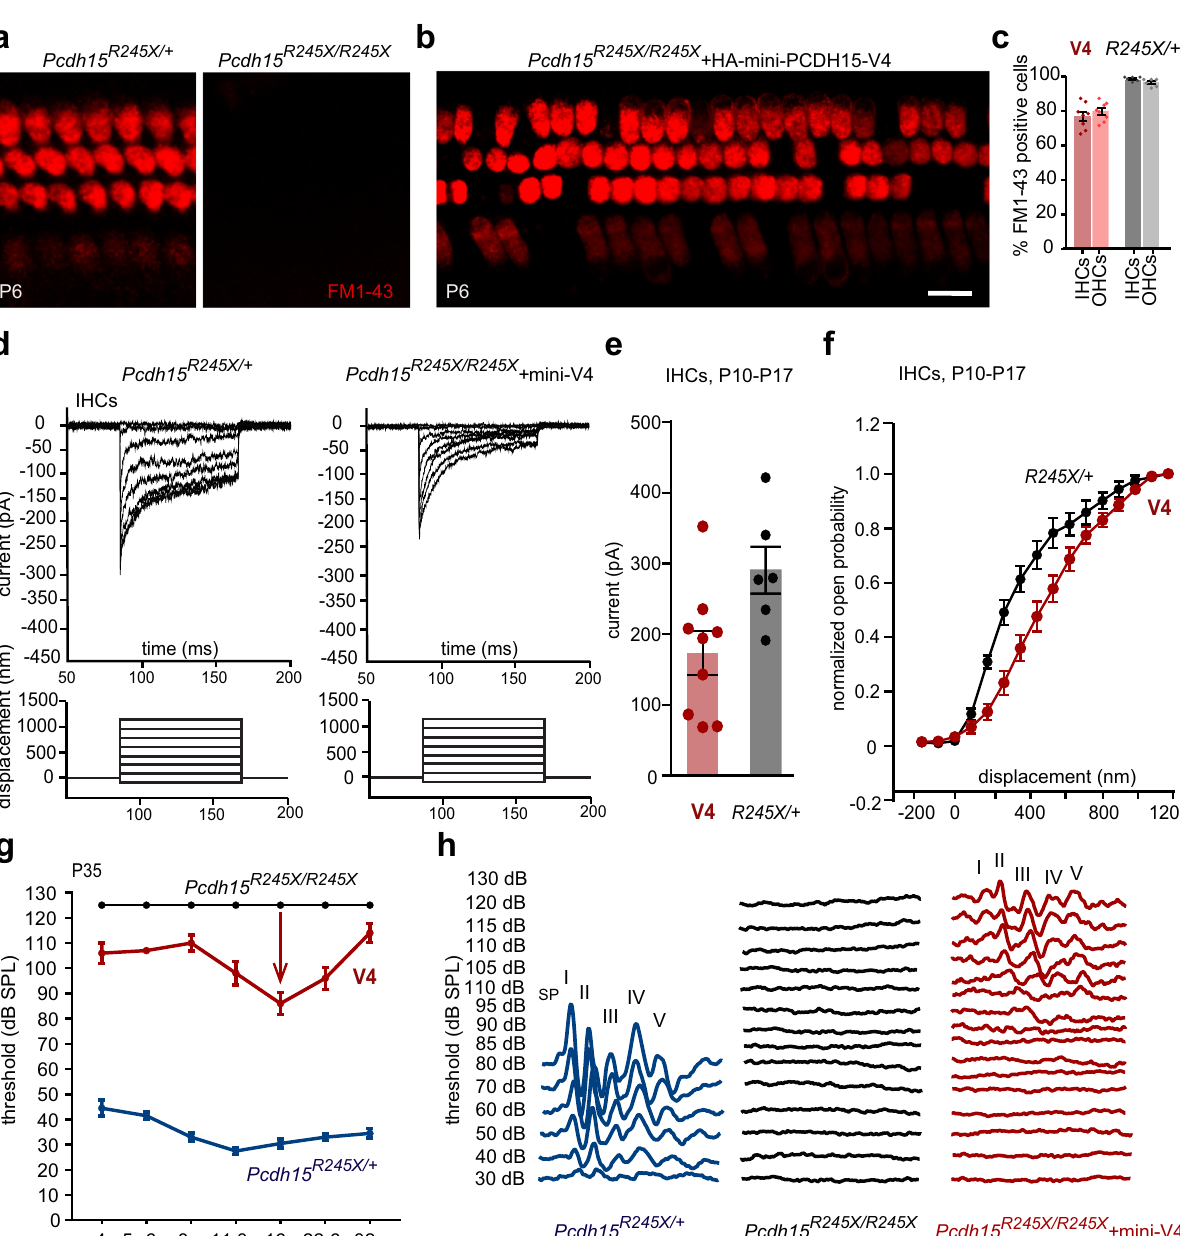
transduction currents at P10-P17 from Pcdh15 R245X/+ controls ( n =6 cells) and Pcdh15 R245X/R245X knockoutstreatedwithAAV-mini-PCDH15-V4( n =9cells).Cellsfrom fi ve separate Pcdh15 R245X/+ cochleas and six separate Pcdh15 R245X/R245X treated knock- out cochleaswere studied. f Normalizedopen probabilityasa function ofstimulus probe displacement for Pcdh15 R245X/+ controls (black, n =6 cells) and treated Pcdh15 R245X/R245X knockouts (red, n =9 cells). g Average auditorybrainstem response (ABR) thresholds as a function of frequency in P35 Pcdh15 R245X/+ controls (blue, n =10), uninjected knockout (black, n =4) and knockout mice injected with AAV- mini-PCDH15-V4mice(red, n =5). h RepresentativeABRtracesatP35fromcontrols, uninjected knockout mice, and treated knockout mice. SP summating potential. Scale bars: ( a , b ) 10 µ m. All data are presented as mean values±SEM. Source data are provided as a Source Data fi